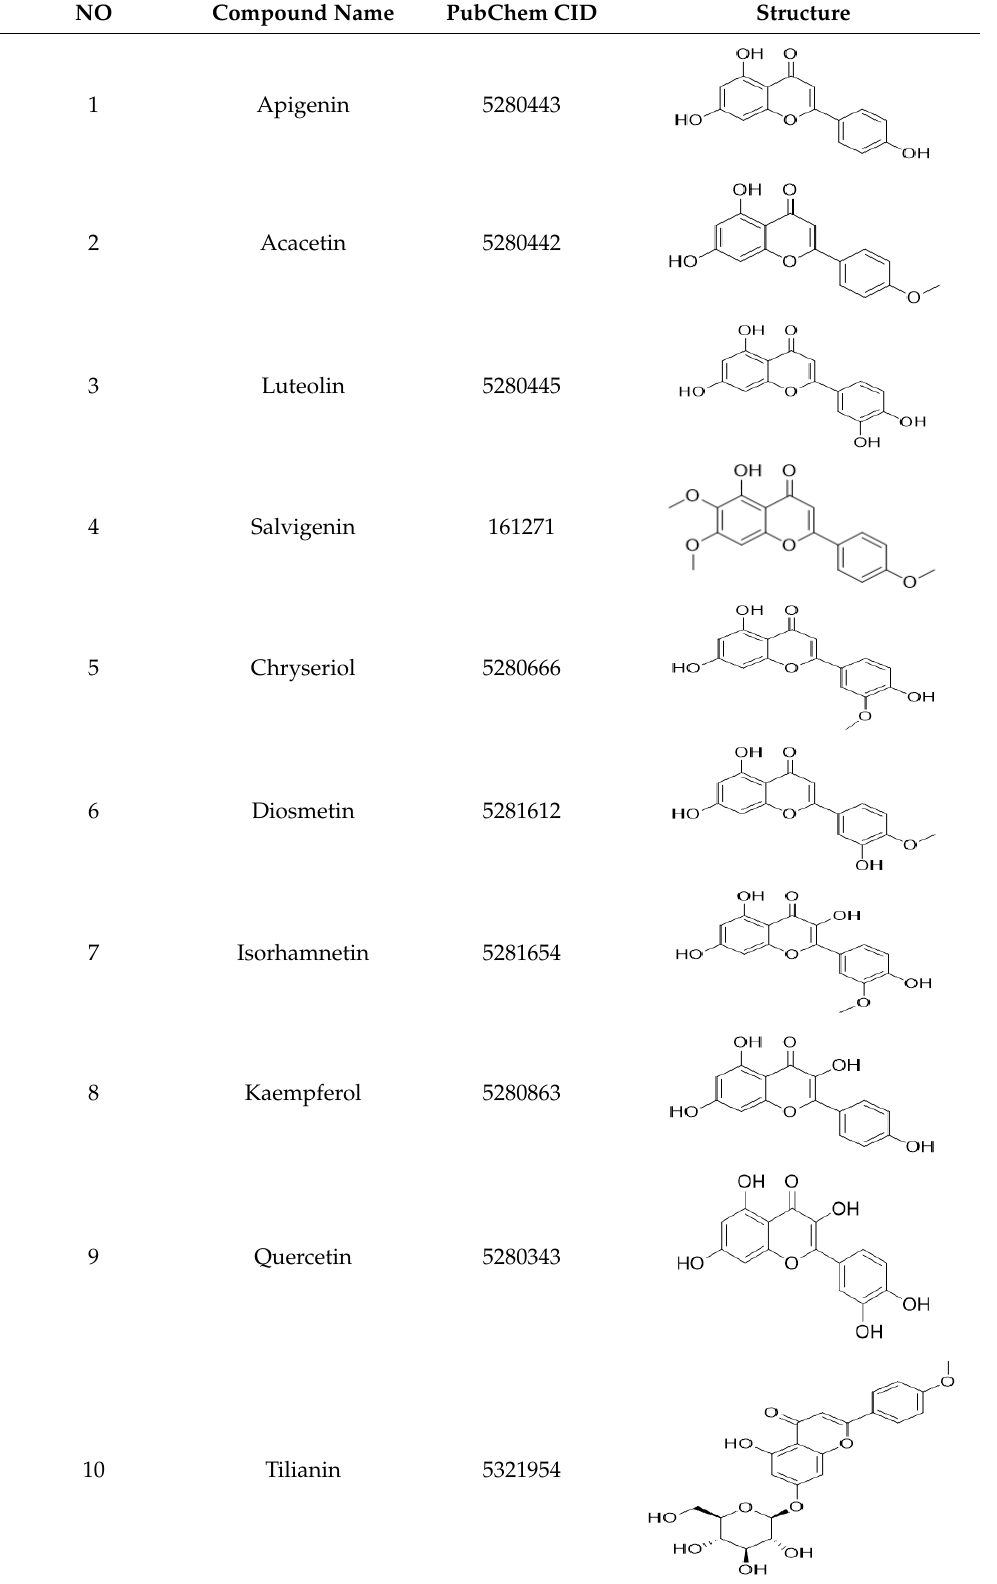
Table 2. The chemical structure of flavonoids in TFDM.